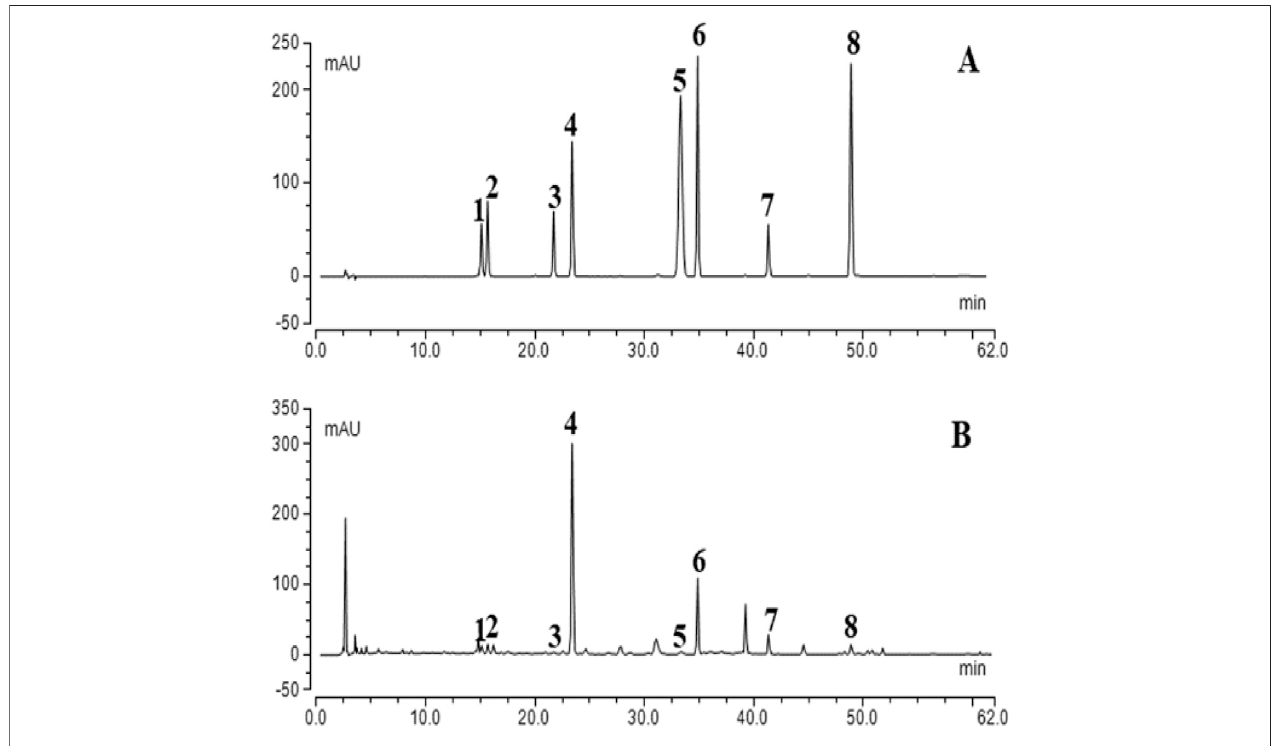
FIGURE 1 | Typical chromatograms of mixed standard compounds (A) and CGGD (B) . (1) liquiritin apioside, (2) liquiritin, (3) isoliquiritin apioside, (4) baicalin, (5) cinnamic acid, (6) wogonoside, (7) glycyrrhizic acid, and (8) wogonin.